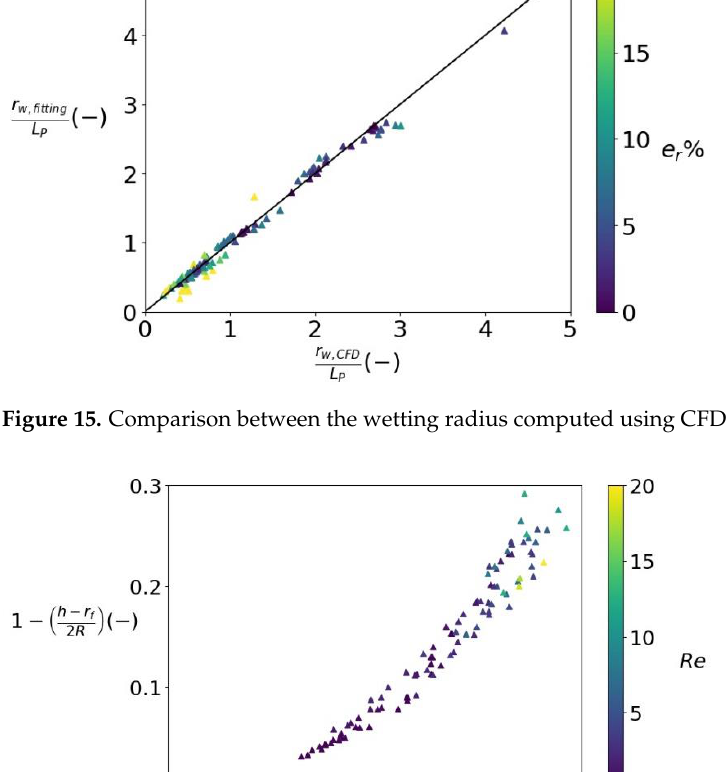
Figure 15. Comparison between the wetting radius computed using CFD simulations and fitting.